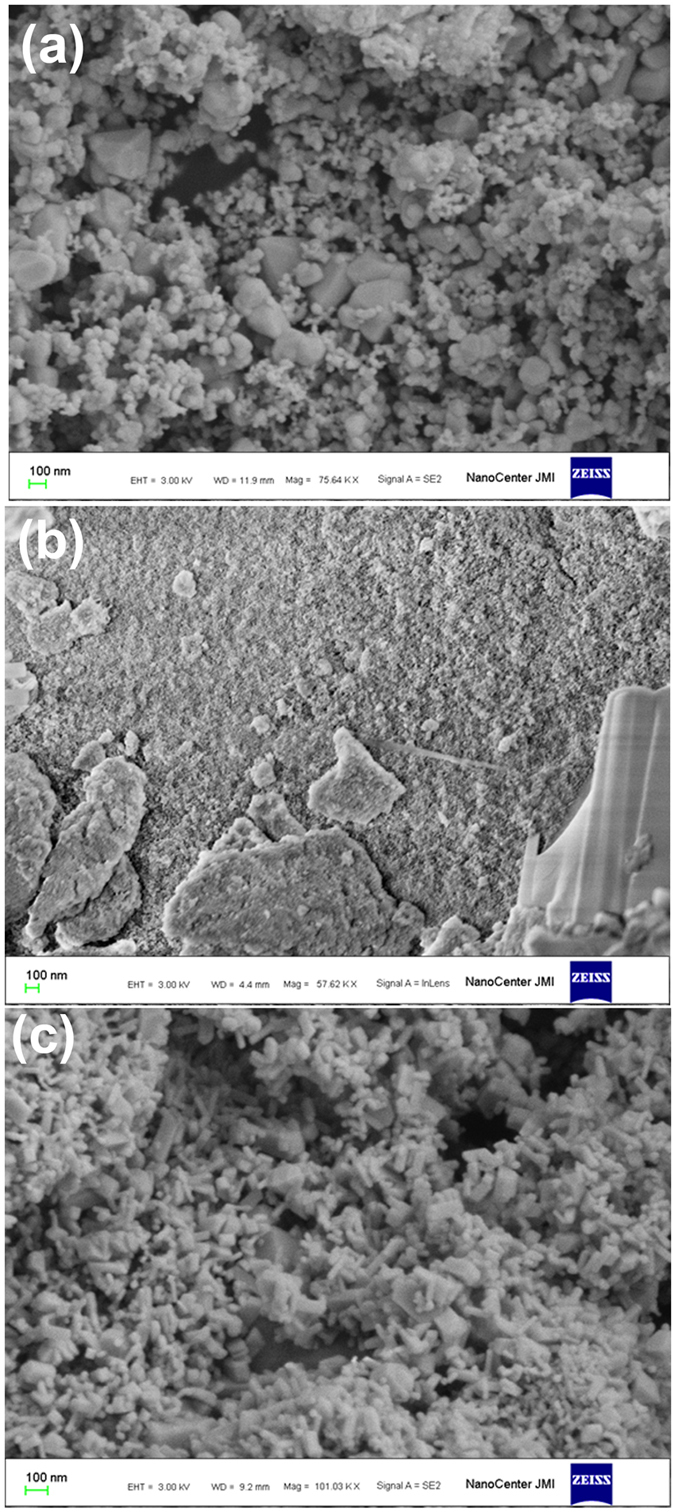
Field emission scanning electron microscopic image of (a) pristine SnO2 powder, (b) Ni-SnO2 powder and (c) Cr-SnO2 powder.